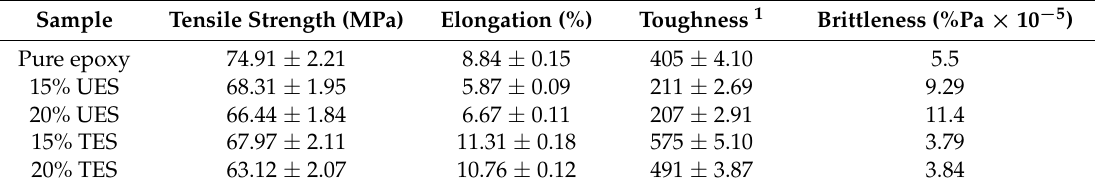
Figure 9. Tensile stress–strain curve of UES and TES filled epoxy composites on various compositions. Table 6. Tensile and toughness values of composites.